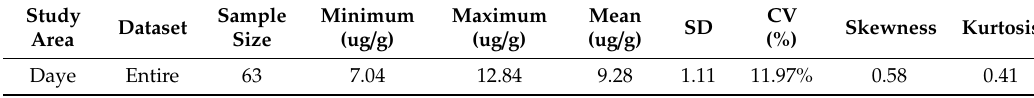
Table 2. Statistics of As concentrations for the collected soil samples.